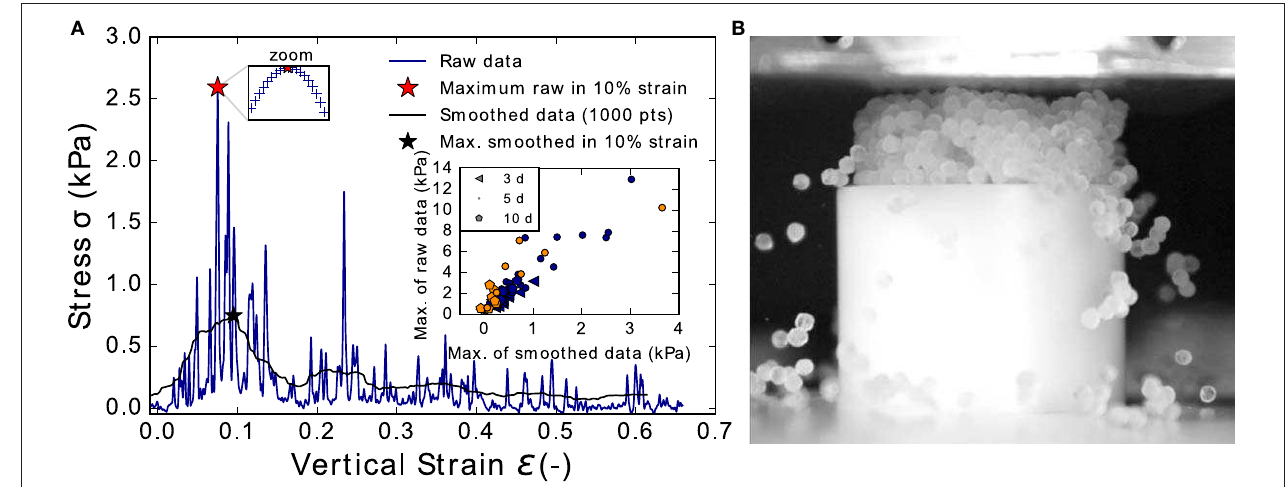
FIGURE 8 | Compression experiment of a poured ice bead sample after 5 days sintering. (A) Example of stress-strain curve as experimental result: the blue curve shows the raw data, the black curve its smoothed version, which was calculated with a moving average over 1,000 data points. The magnification of the blue maximum shows that the sampling rate of 10kHz resolved the fracture. The maxima within the first 10% of strain were extracted from each curve, as marked by the stars. The inset shows the relation between the maxima of raw and smoothed data. (B) Photography of sample during compression: single particles and clusters of particles break out and lead to the pronounced peaks shown in (A) and a changing contact area during compression.